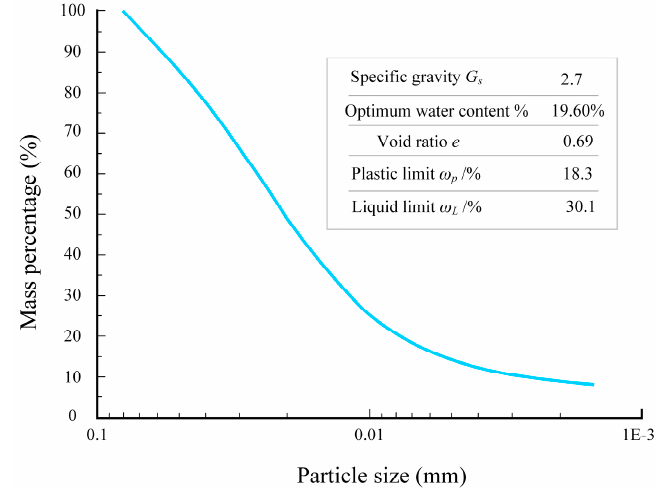
Figure 5. Silt particle size curve and physical properties.